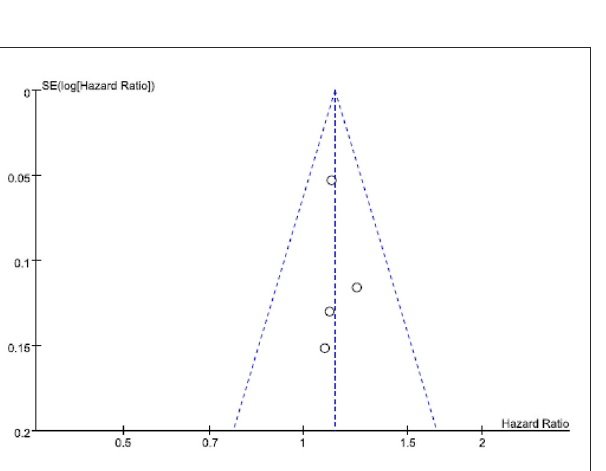
FIGURE3 Funnel plot of log-transformed relative risks (RRs) of dementia associated with shift work and standard errors for the two studies.